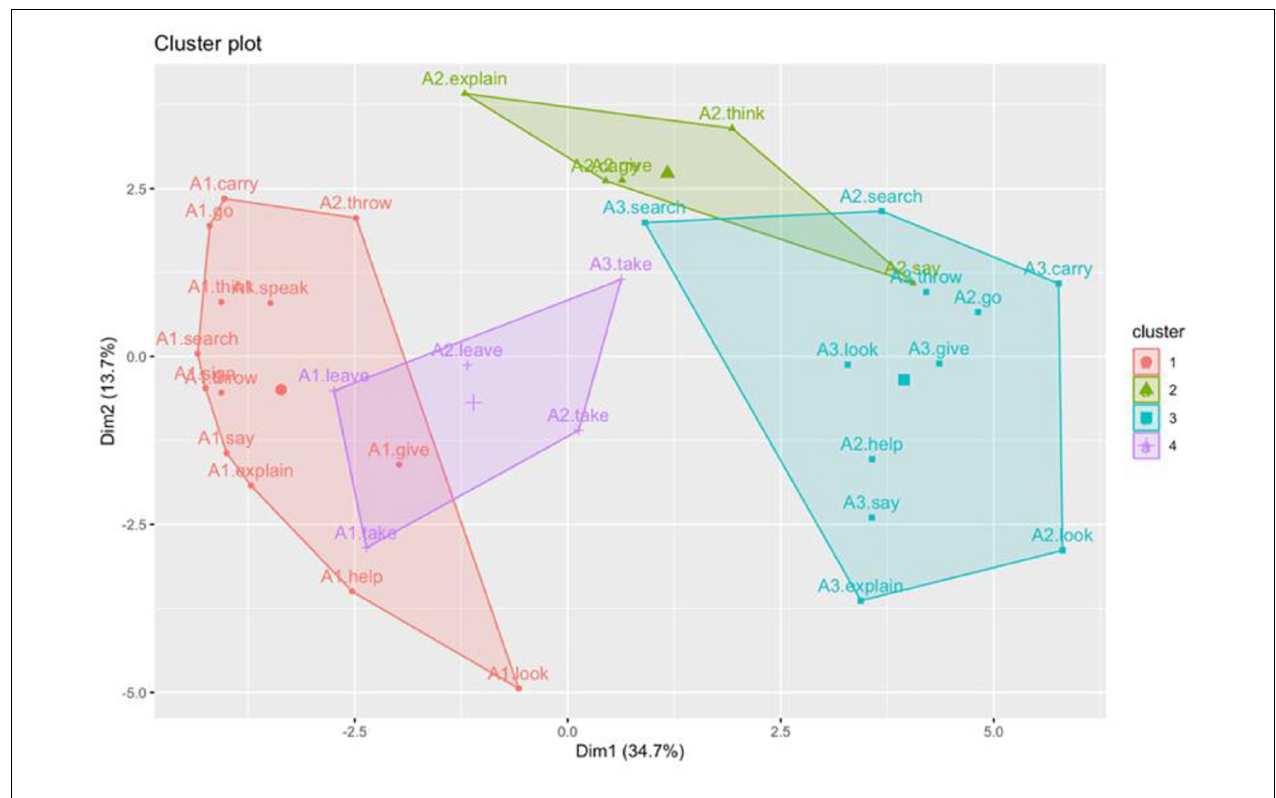
FIGURE 4 | A scatterplot of the four argument